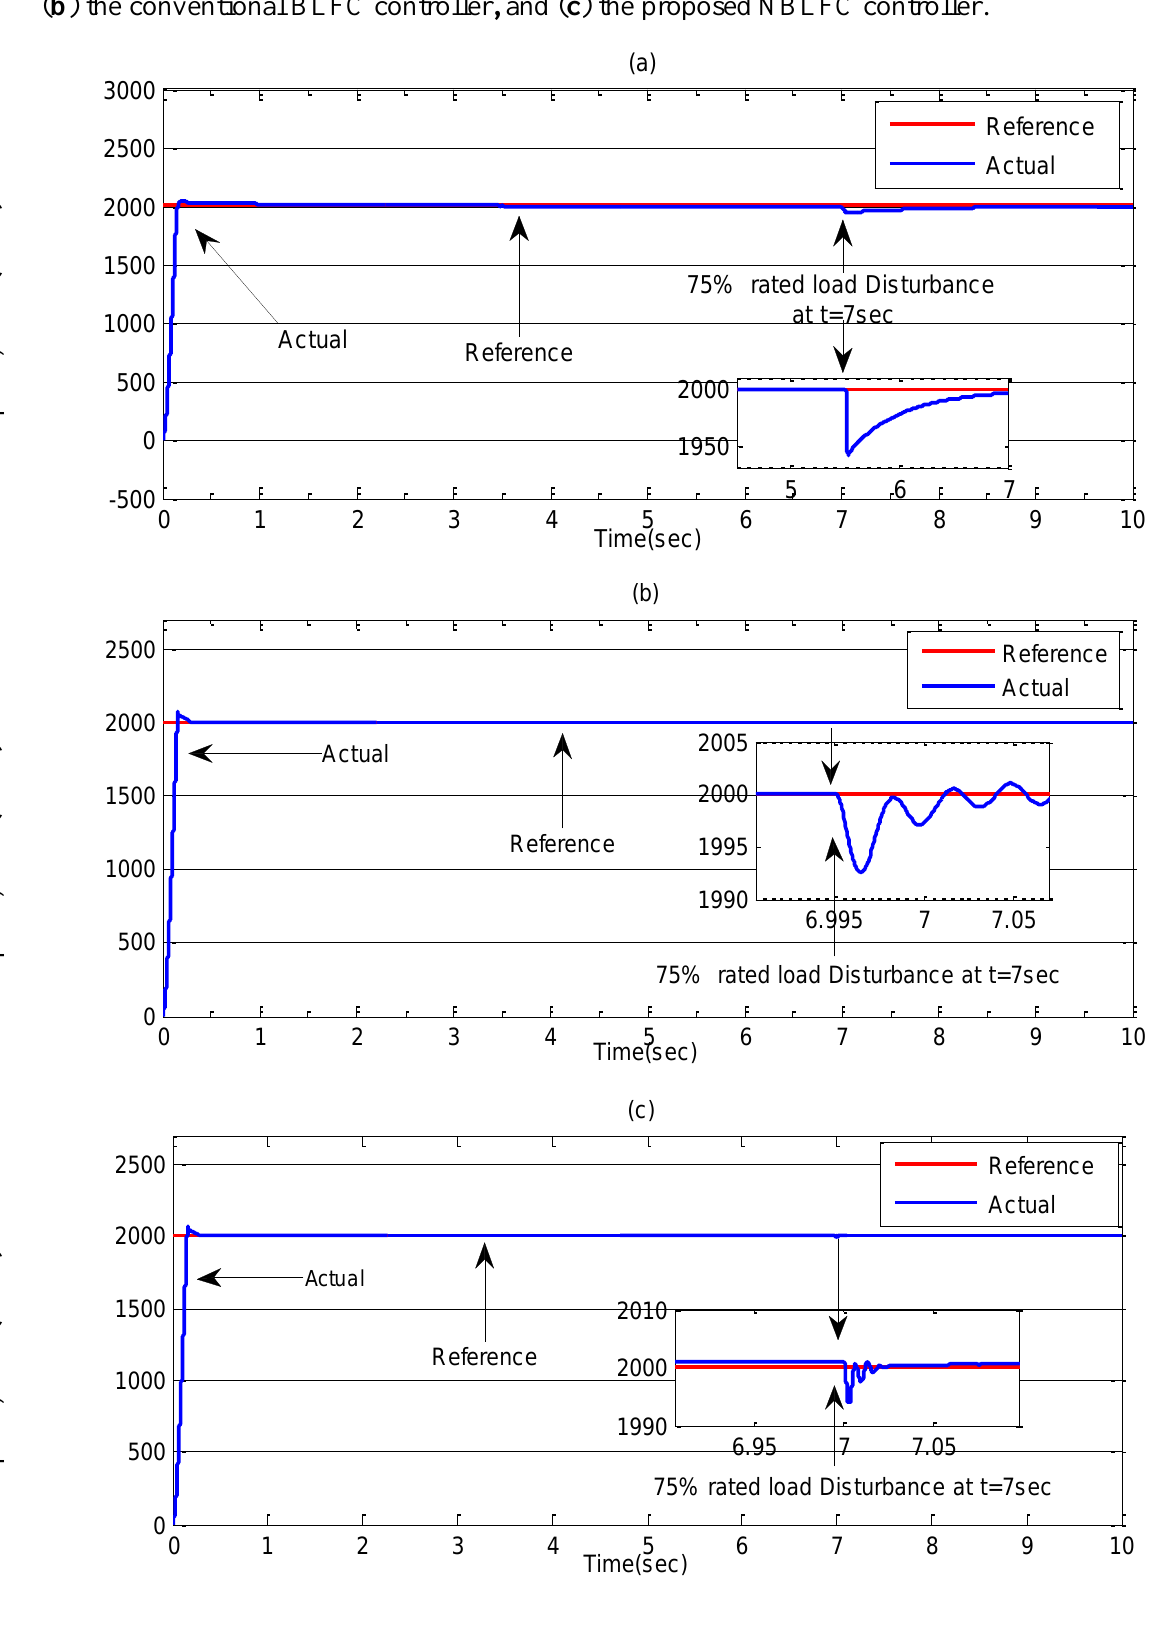
Figure 9. Simulated speed responses-based IM drive in Case-2 ; ( a ) the tuned PI controller, ( b ) the conventional BLFC controller , and ( c ) the proposed NBLFC